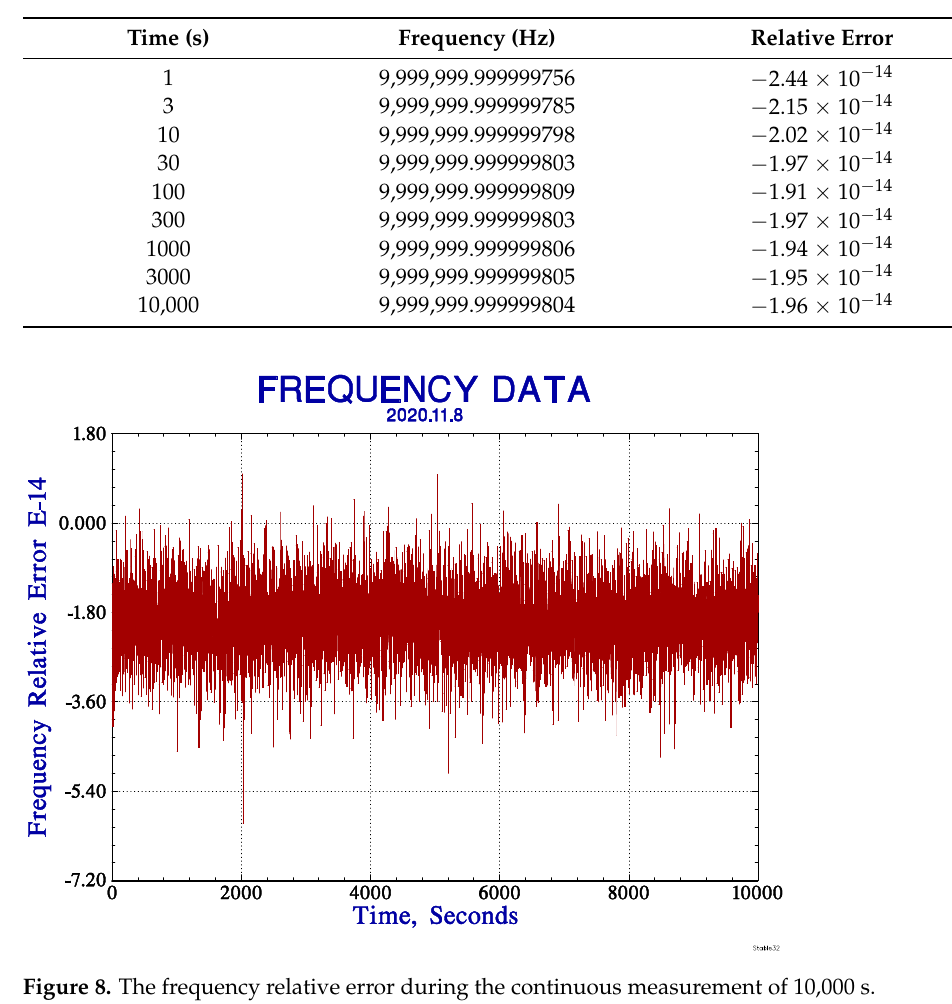
Table 2. The requency measurement average and relative error.